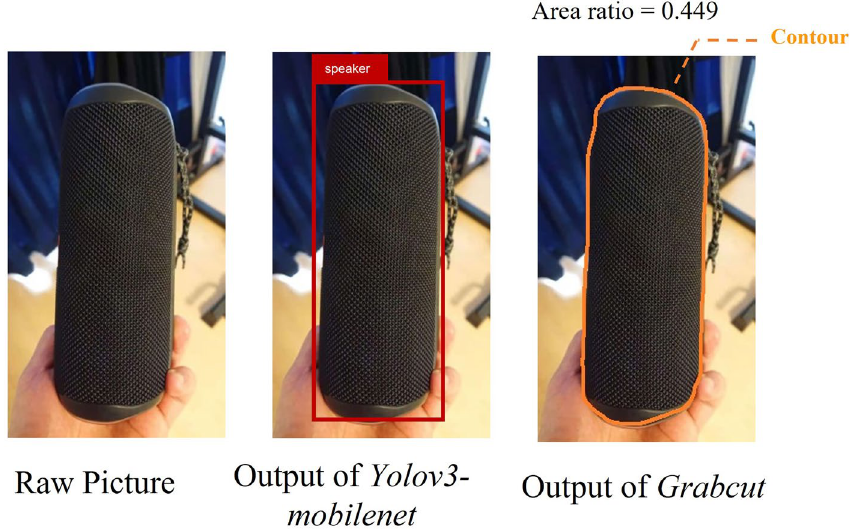
Figure 5. Illustration of the output of Yolov3-Mobilenet and Grabcut. The left panel shows the input (i.e., raw picture) of our models; the middle panel shows the output of Yolov3-mobilenet and the right panel shows that of Grabcut. Yolov3-mobilenet detected the approximate location (red rectangle) of the speaker in the raw picture. Grabcut detected the pixel-level contour (in orange) of the speaker based on the Yolov3-mobilenet output. The area ratio can then be easily computed from the output of Grabcut. The area ratio in this picture was 0.449. The picture used in this figure wa s taken by the first author. Therefore, thi s was only used for illustration but not a real example in our two